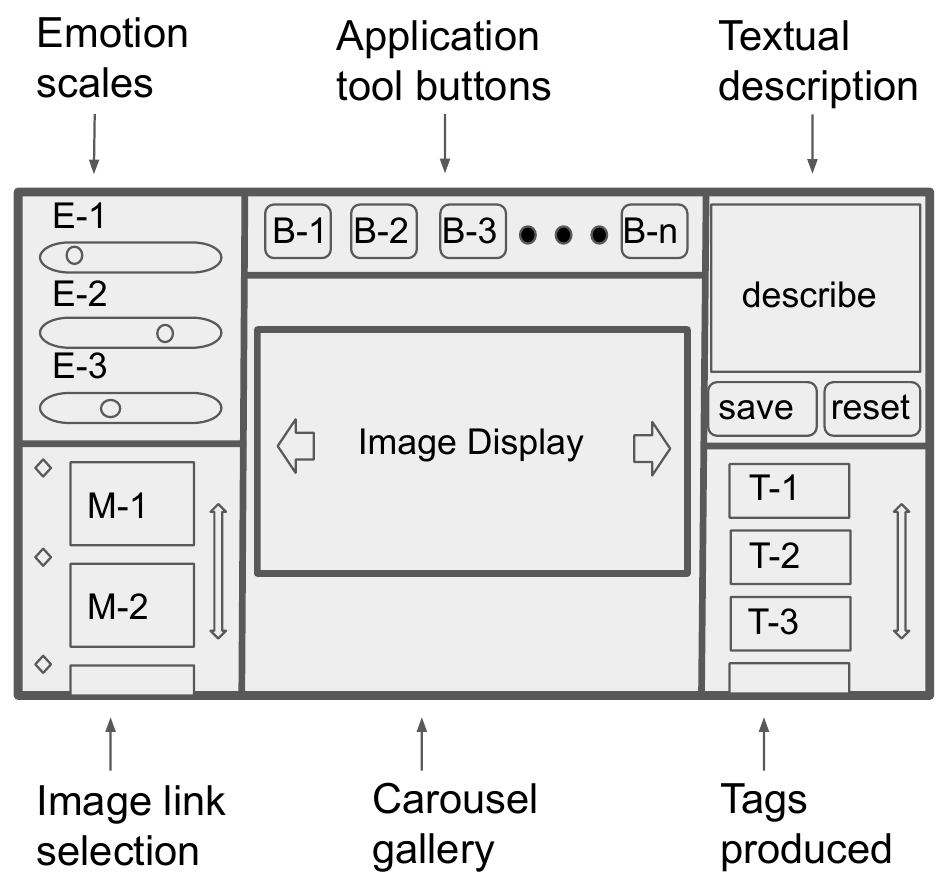
Figure 1. The wireframe model of the main Tagasaurus UI. The user can view each image individually within the gallery pane, insert their emotion perception values (sliders E), link the image to other images (check boxes M), use application buttons for actions such as import/delete/export (buttons B) and provide an image description which is processed to produce tags (list T). The user is required to press the save button when they have completed the